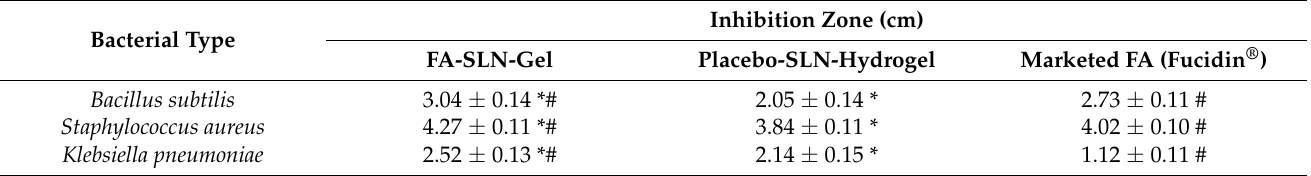
Table 3. Microbiological activity of examined formulations counter to different bacterial strains.